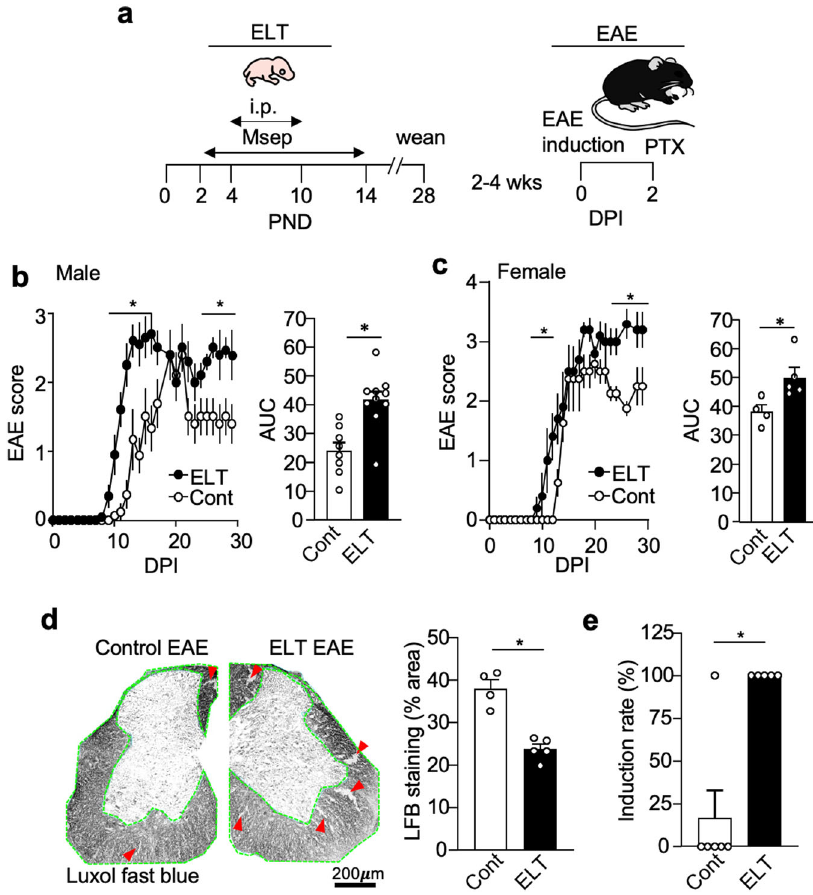
Fig. 1 ELT impacts EAE susceptibility, severity, and duration in both male and female mice. a Schematic representation of experimental procedure. PND and DPI indicate postnatal day and day post-EAE induction, respectively. b Mean clinical EAE scores and cumulative scores of male mice (Cont EAE: n = 8, ELT-EAE: n = 10). c Mean clinical EAE scores and cumulative scores of female mice (Cont EAE: n = 4, ELT-EAE: n = 5). d Spinal cord sections of EAE mice stained for myelin using Luxol-fast blue at 20 dpi (Cont EAE: n = 4, ELT-EAE: n = 5) with quantitative analysis of stained area. Green outline indicates analyzed white matter region of interest. Red arrows indicate representative demyelination regions. e EAE induction rate among mice treated with low-dose Mtb (50 μ g/mouse, Cont EAE: n = 6, ELT-EAE: n = 5). Results are representatives of at least two independent experiments. Each dot represents averaged data per animal. Data are represented as mean ± SEM. Two-tailed Student ’ s t -test, * P < 0.05. Exact P values for asterisks: b 0.0010, c 0.0288, d 0.0004, and e